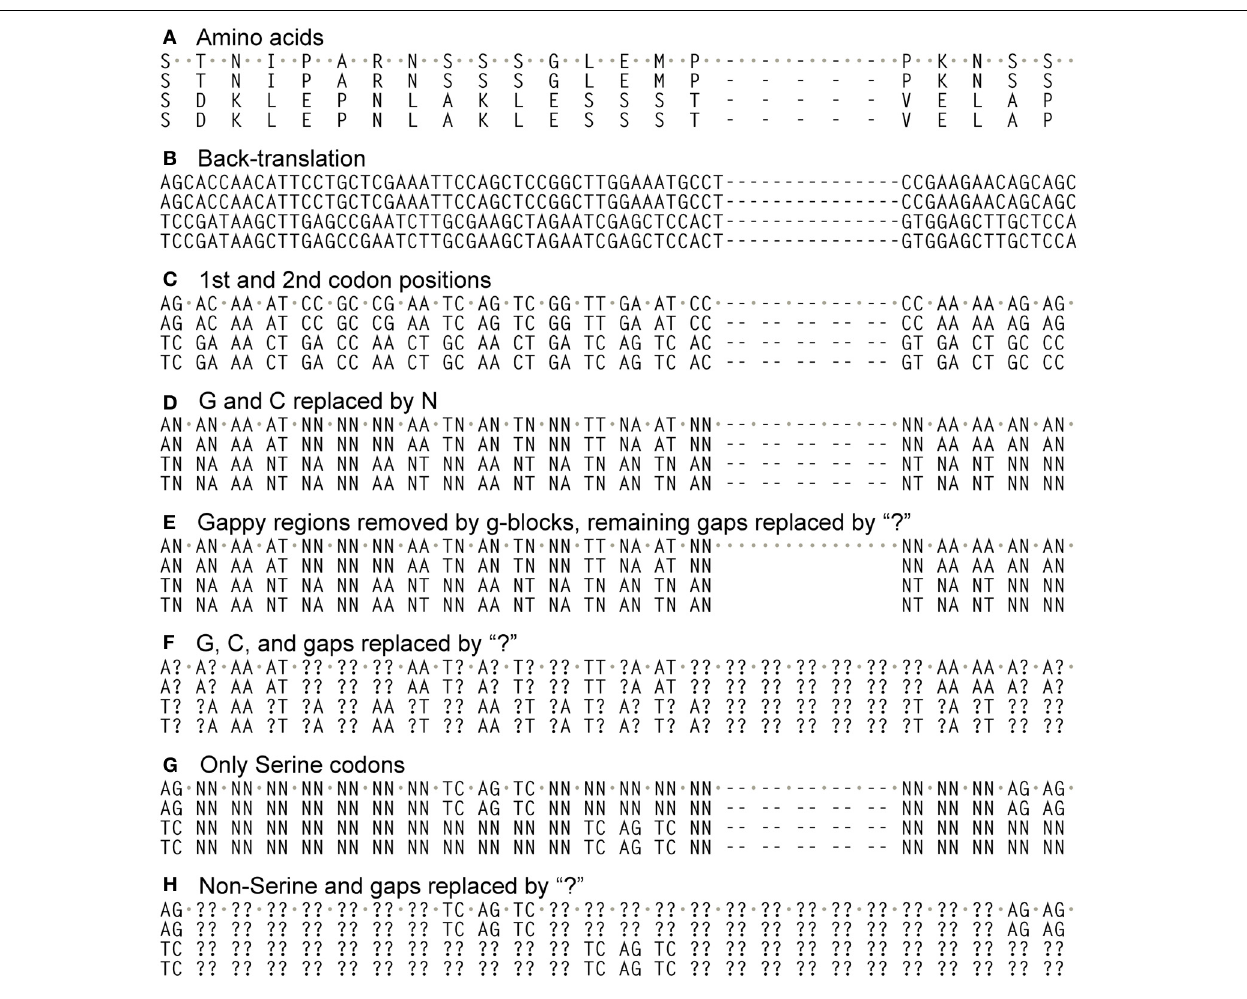
FIGURE 1 | Different alignments used in this study. Alignments began by translating coding sequences and aligning them with ClustalW2 (“gapopen” option set to 15), and then back-translating them into nucleotides (A,B) . From these only the 1st and 2nd codon positions were taken (C) , and then all G and C nucleotides converted to “N” (D) , which is read as “any nucleotide” in the phylogenetic program